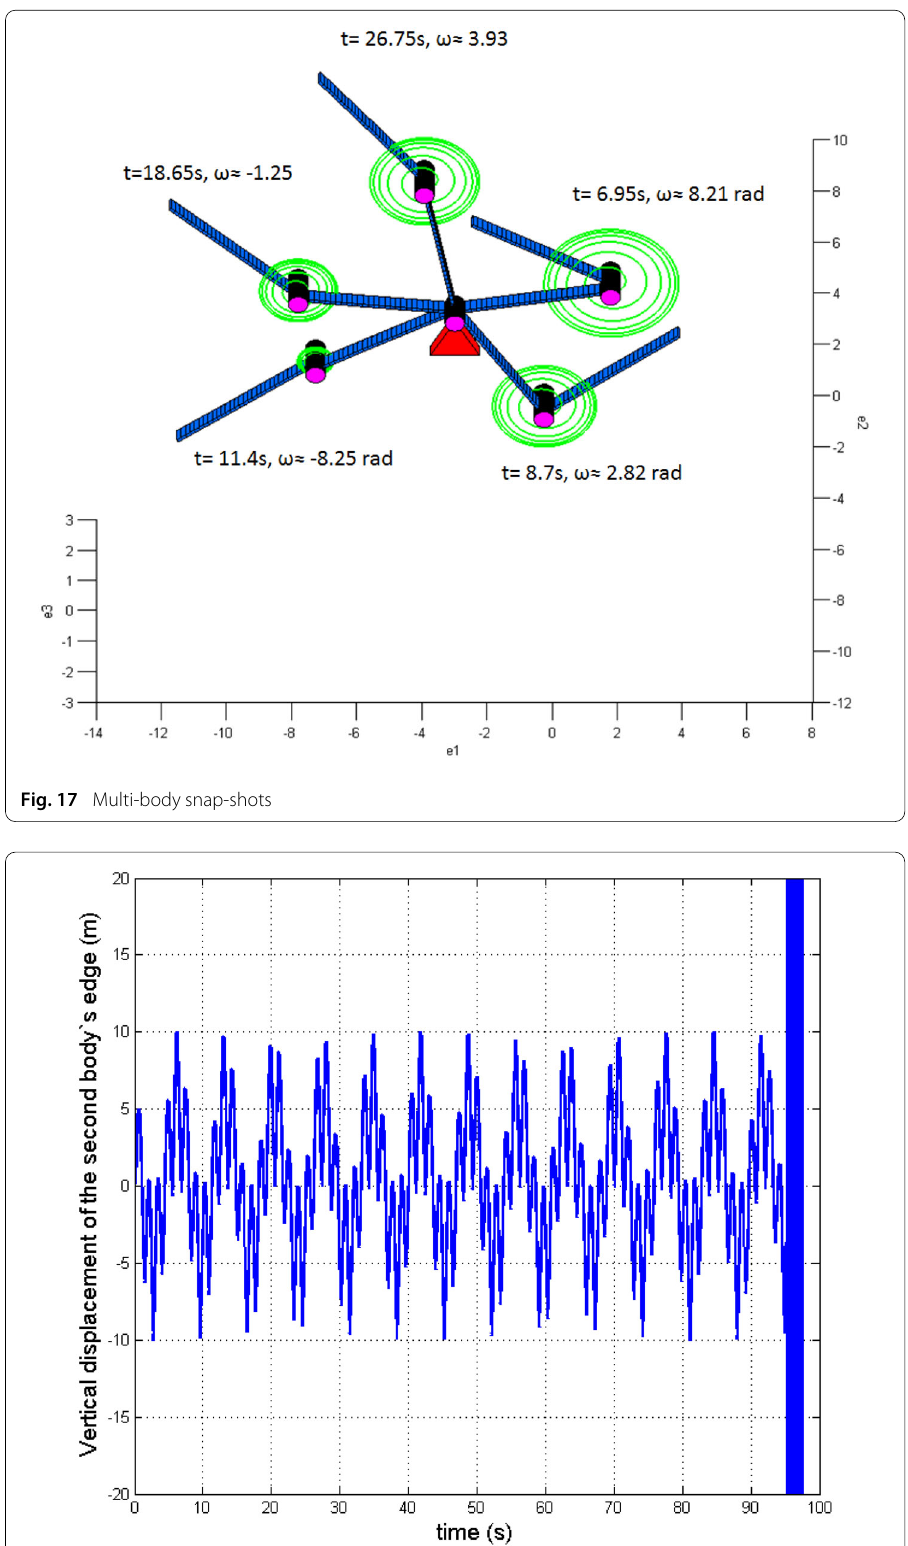
Fig. 18 Displacement time history—classical midpoint rule for (cid:15) t = 10 − 3